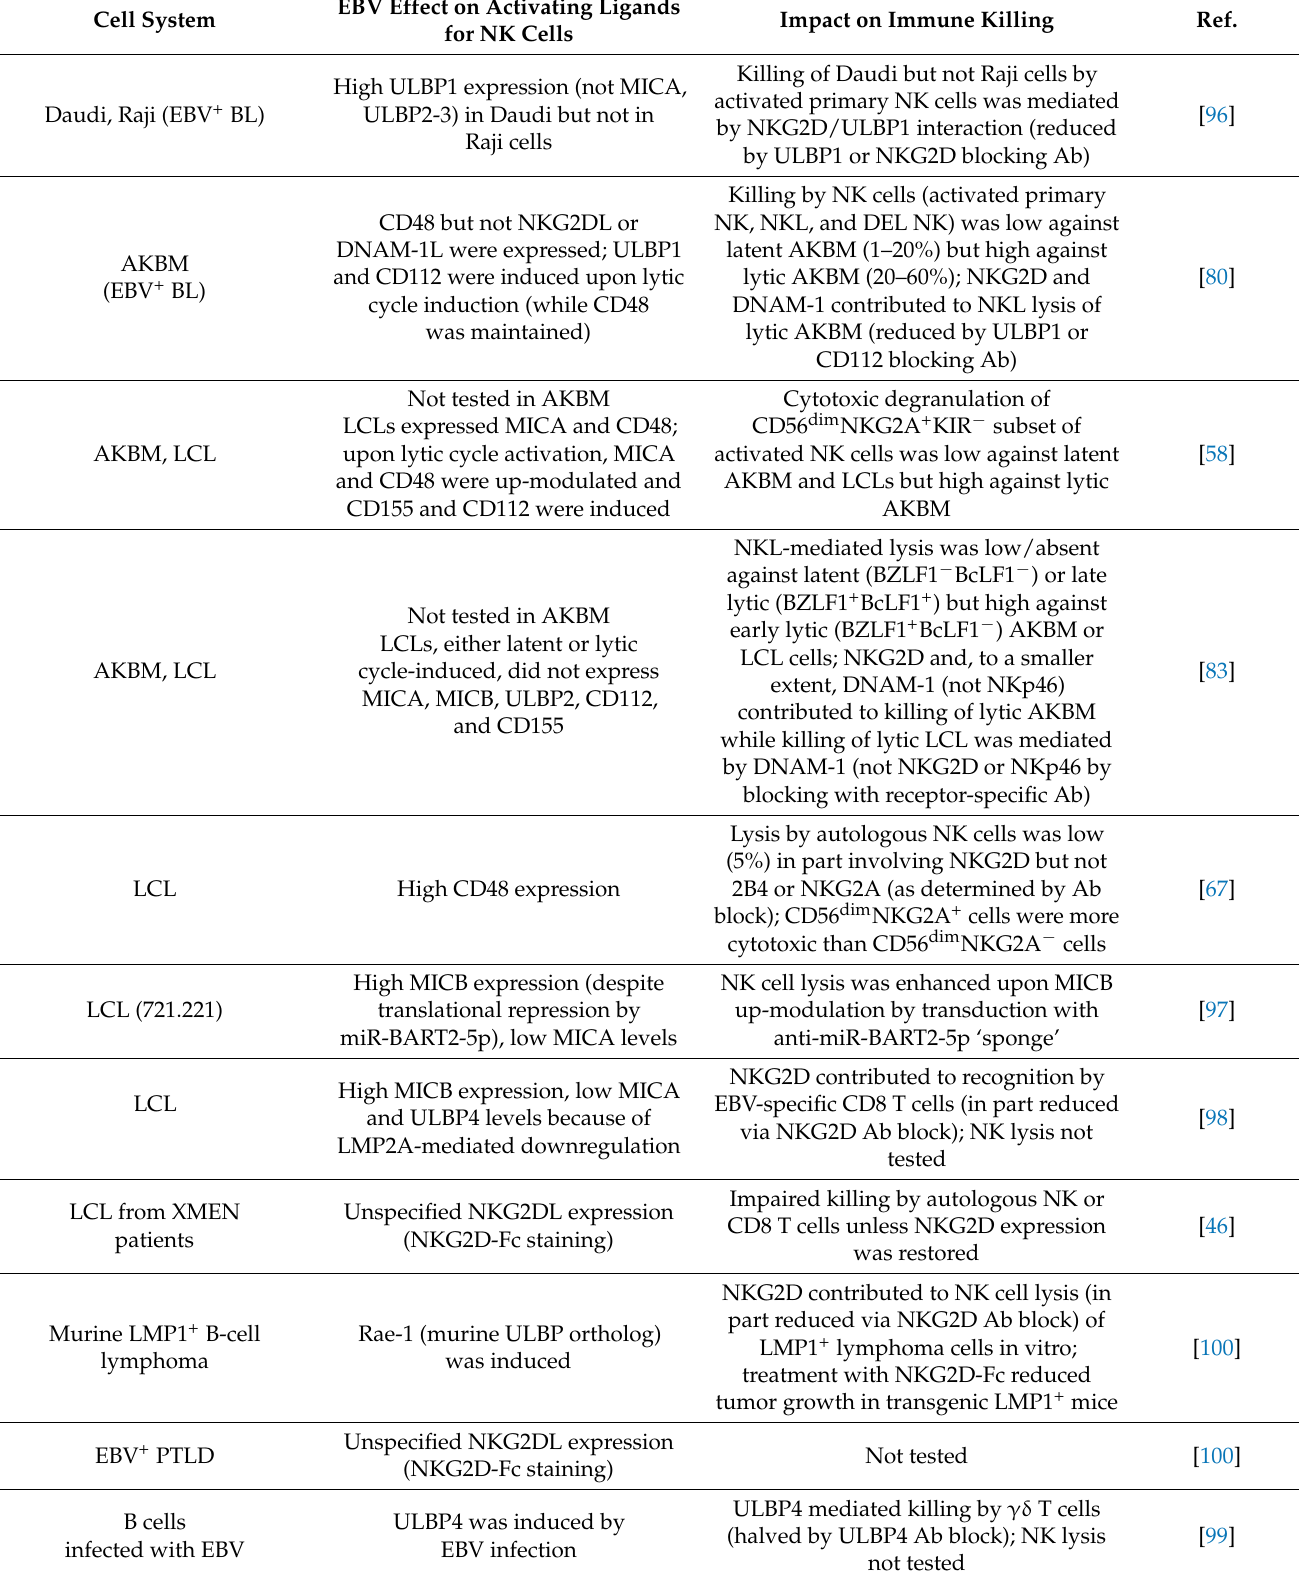
Table 2. Modulation of NK cell-activating ligands by